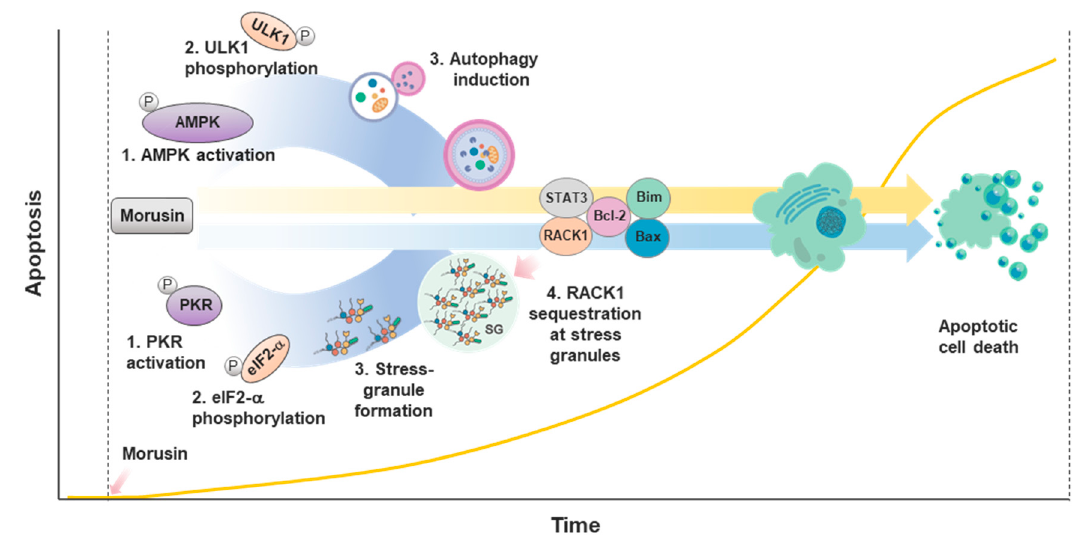
Figure 3. Morusin-induced autophagy and stress granule (SG) formation inhibits induction of apoptosis at early times of the stress response. Morusin induces apoptosis, autophagy and SG formation. However, induction of autophagy and SG formation occurs ahead of apoptosis induction at the early times of morusin treatment, resulting in a delay of the induction of apoptosis.